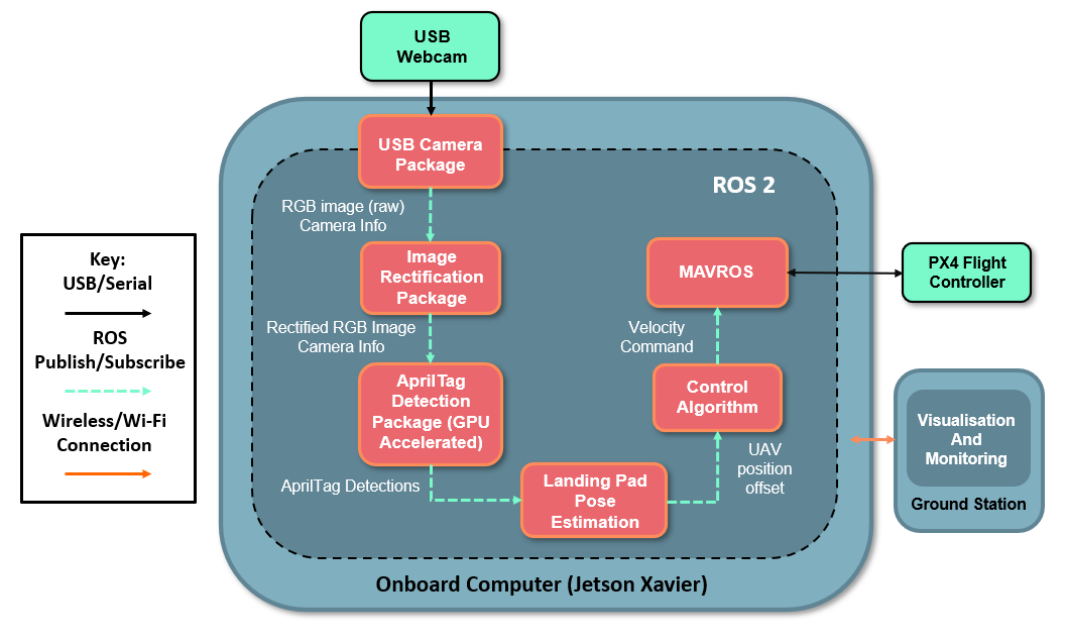
Figure 4. Architecture of the UAV auto-landing